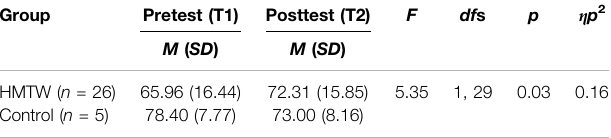
TABLE 2 | Main effect of time on primary outcomes (CSBS